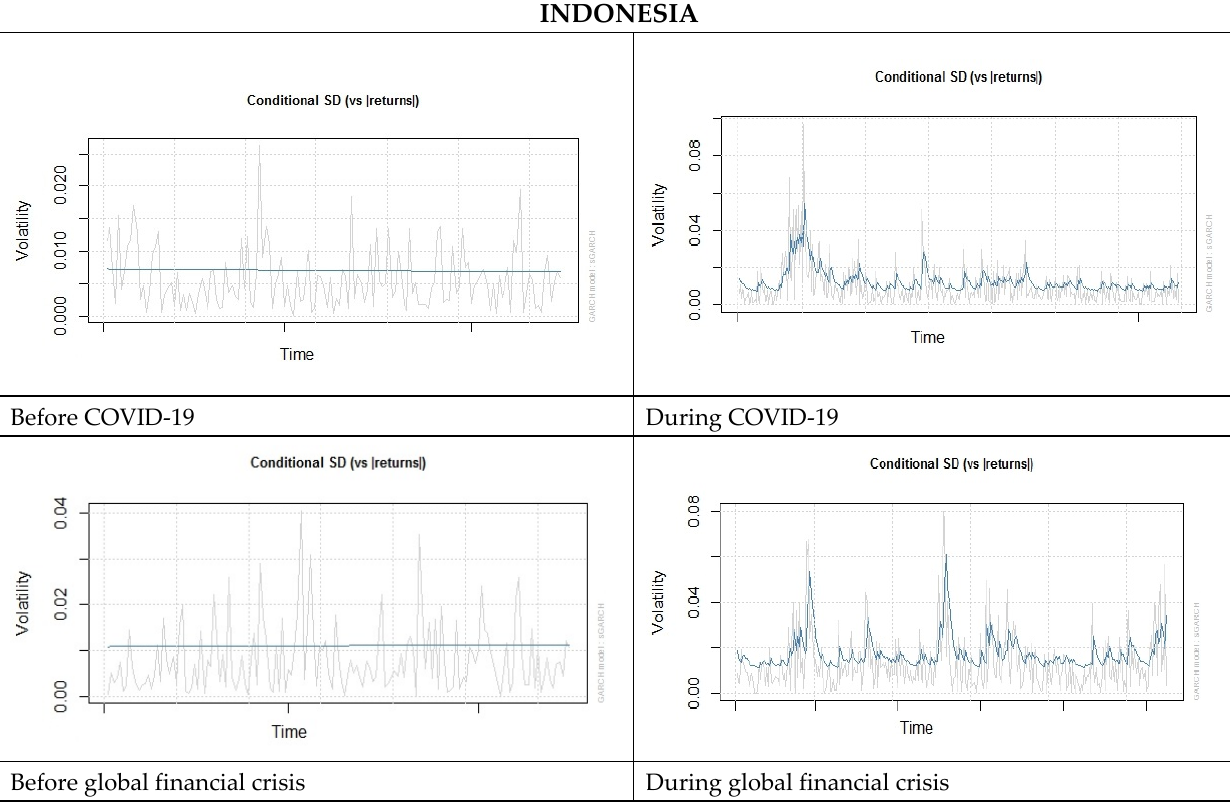
Figure 4. Conditional variances of the GARCH MODEL. Table 10 proves the stability of the model. The non ‐ significance of the Ljung ‐ Box test demonstrates that residuals do not fit the ARMA model, which means that there is no serial correlation. All p ‐ values are greater than 0.01, except lag (5) during the crisis, which justifies the failure to reject the null hypothesis confirming that there is no serial correlation of GARCH model residuals. Table 10. Weighted Ljung ‐ Box Test on Standardized Residual: d.o.f = 2.